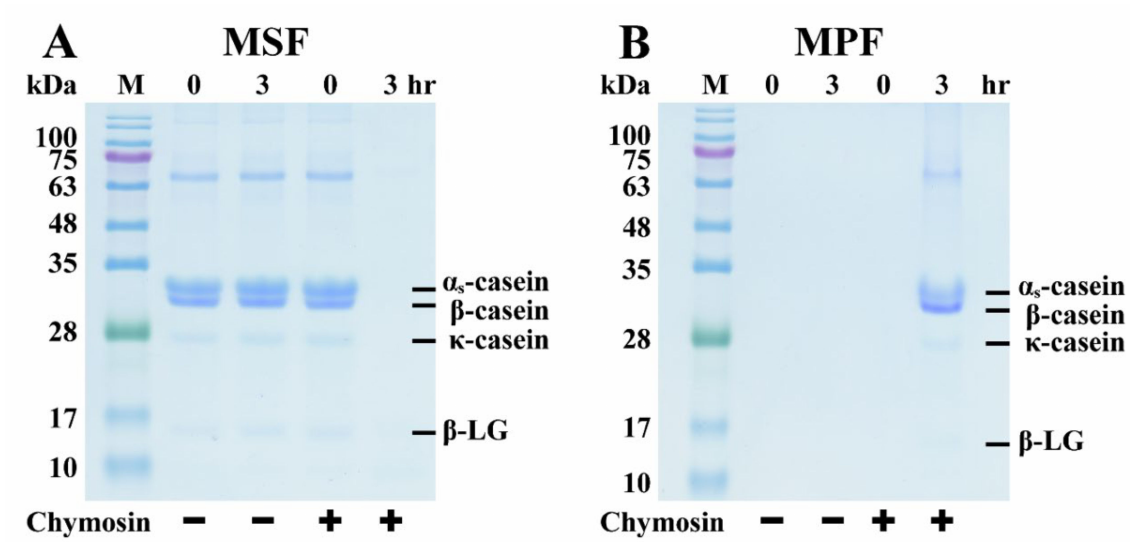
Figure 1. SDS-PAGE analysis of skim milk incubated with/without chymosin (0.03 units/mL) at 30 ◦ C for 0 and 3 h. ( A ) Milk supernatant fraction (MSF); ( B ) milk pellet fraction (MPF). M = protein